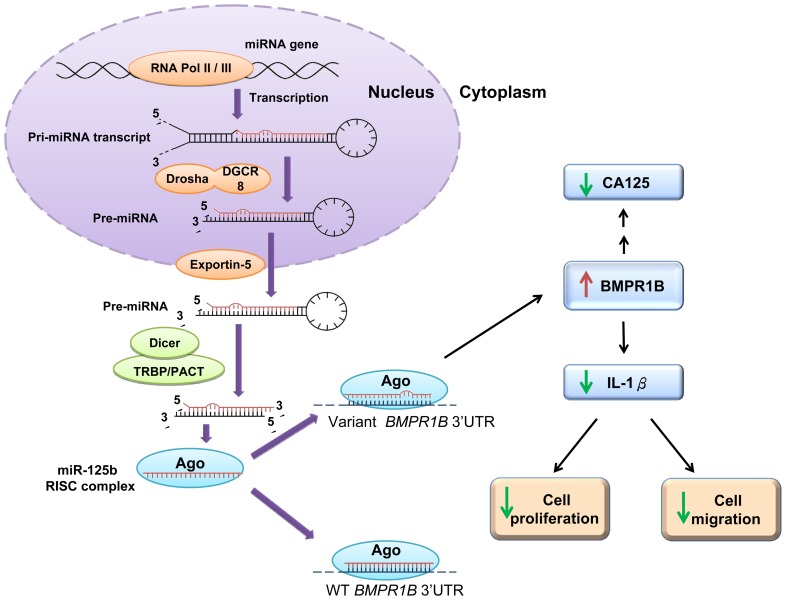
Schematic representation of a proposed model depicting functional influences of genetic variations in BMPR1B 3′UTR on endometriosis development.Mature miRNAs including miR-125b are produced by several processing steps where the microprocessor complex (Drosha/DGCR8), exportin 5 and Dicer/TRBP/PACT complex have been known to involve in. The resulting miR-125b forms a RISC complex with Ago and silences BMPR1B gene by binding to the complementary sequence in BMPR1B 3′UTR. Impaired recognition due to genetic variations in the mir-125b seed region reduces suppressive effect of mir-125b, resulting in up-regulation of BMPR1B. The CA125 level, a biomarker for endometriosis and ovarian cancer, was found reversely correlated with BMPR1B in endometrium cells. Elevated BMPR1B levels in endometrium cells have been proven to reduce cell proliferation and migration activity via down-regulation of IL-1β, indicating a lower risk to develop endometriosis.